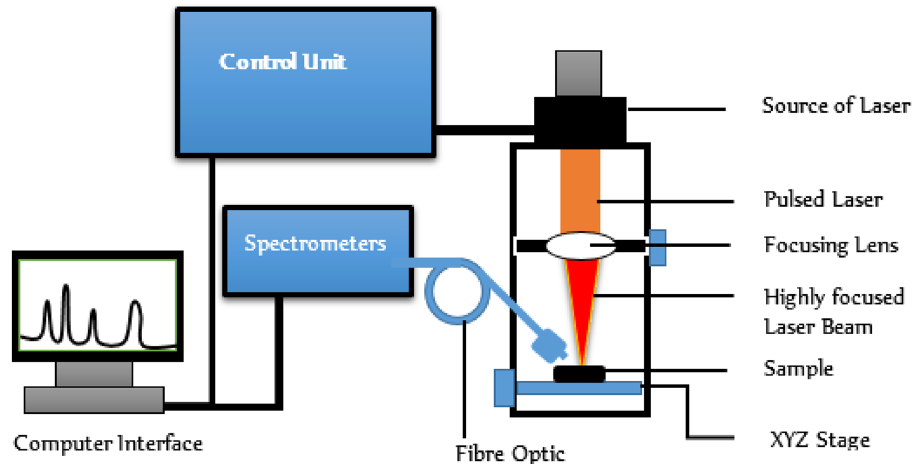
Figure 1. Schematic diagram of the Ocean Optics LIBS